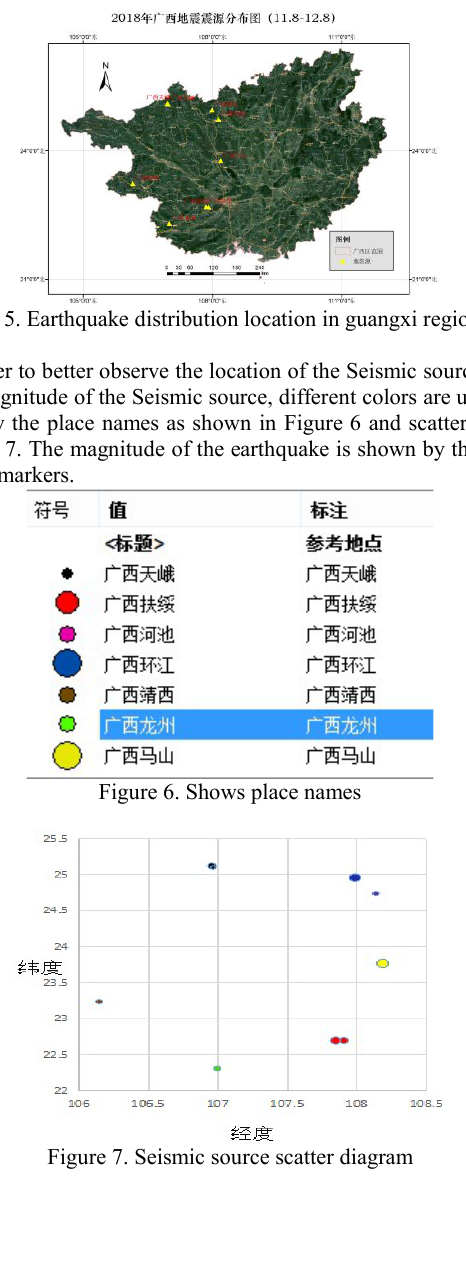
Figure 8. 3D model and focal depth